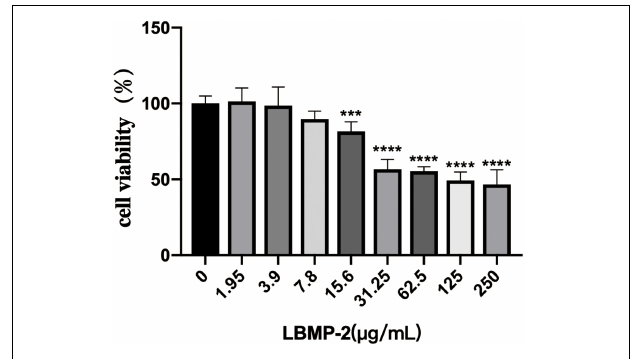
FIGURE 3 | The effect of LBMP-2 on the viability of B16-F10 cells ( n = 6, *** p < 0.001, **** p <